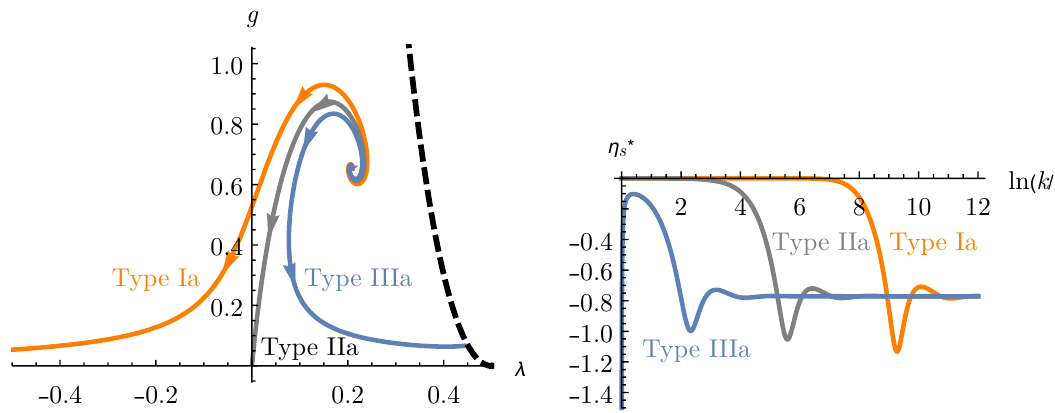
Figure 4 . Three prototypical RG trajectories obtained from numerically integrating the reduced system of beta functions for N s = 1 (left). The (cid:13)ow is governed by the interplay of the NGFP and GFP. The scalar anomalous dimension (cid:17) s along the trajectories is shown in the right diagram. The initial scales k 0 are tuned such that the trajectories in the right diagram are disentangled. Notice that (cid:17) s is negative semi-de(cid:12)nite along the entire RG (cid:13)ow. In the UV ( k ! 1 ) the